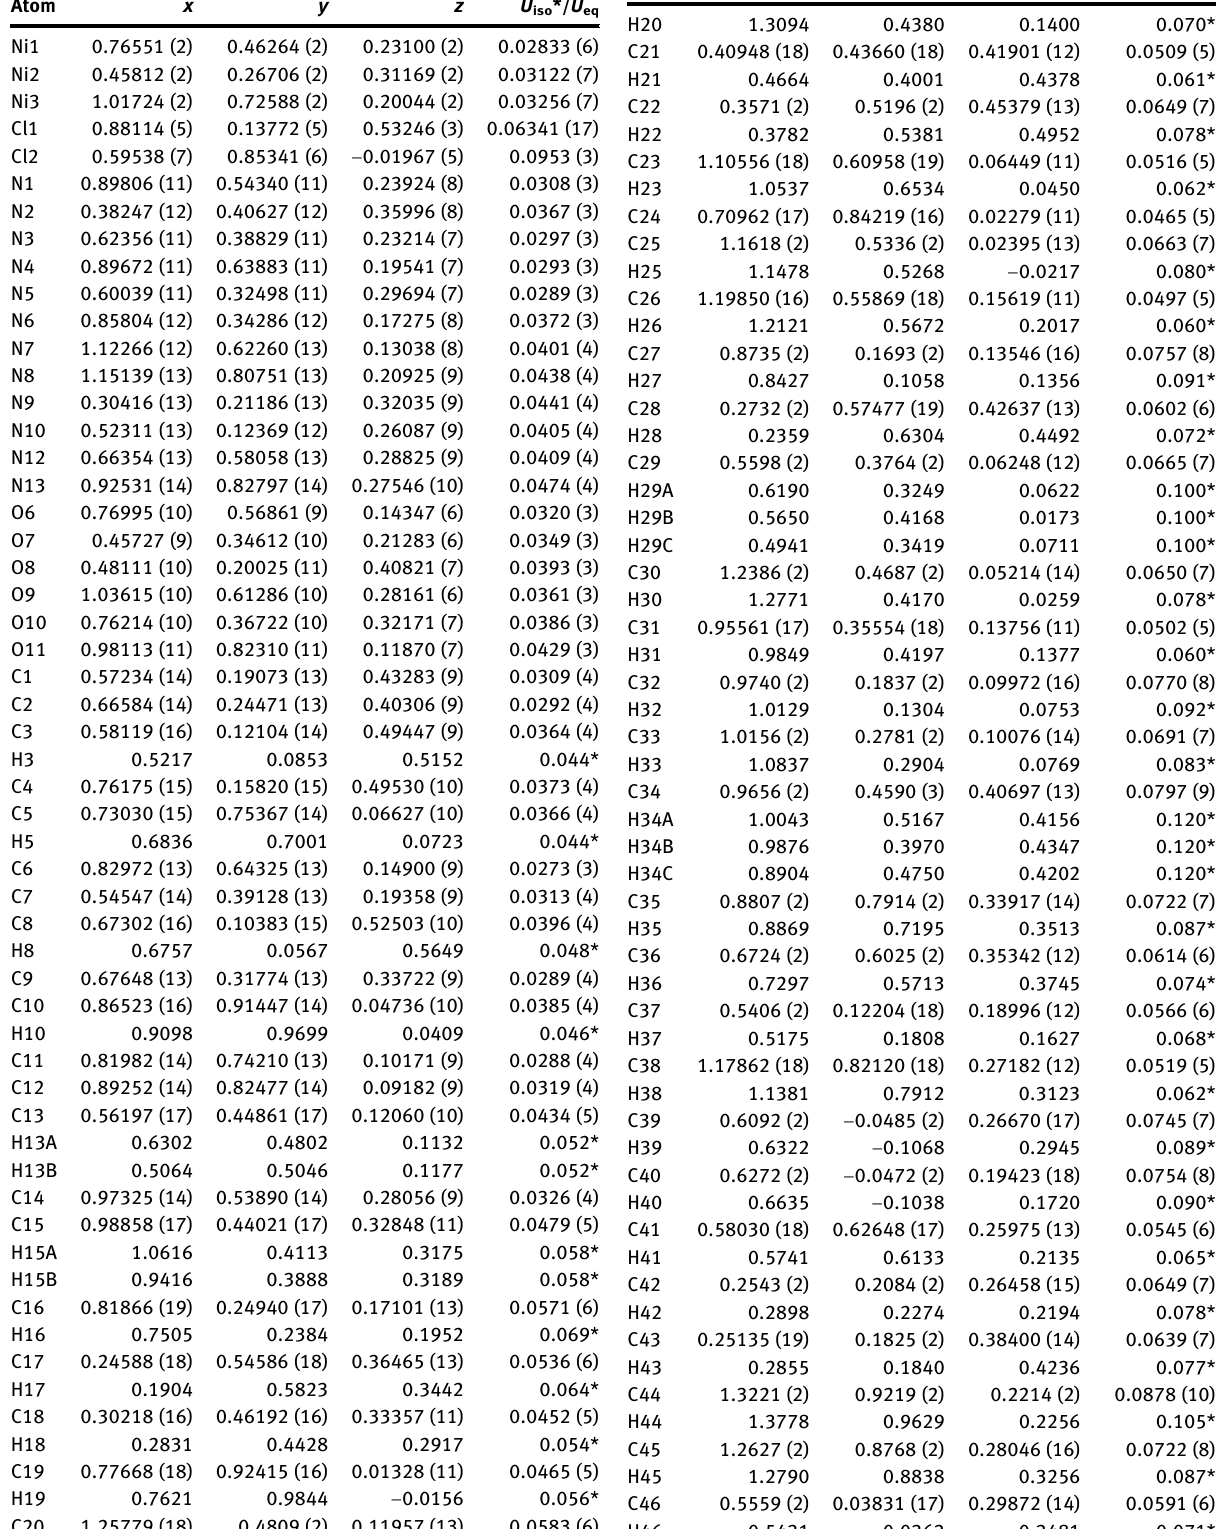
Table  : Fractional atomic coordinates and isotropic or equivalent isotropic displacement parameters (Å 